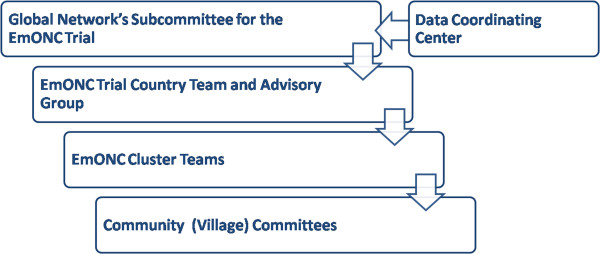
EmONC Study Organization.